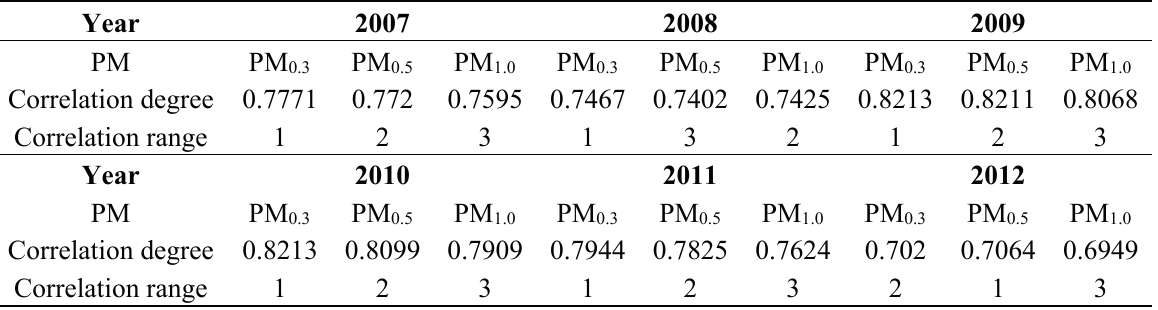
Table 3. Grey correlation degree and its range during